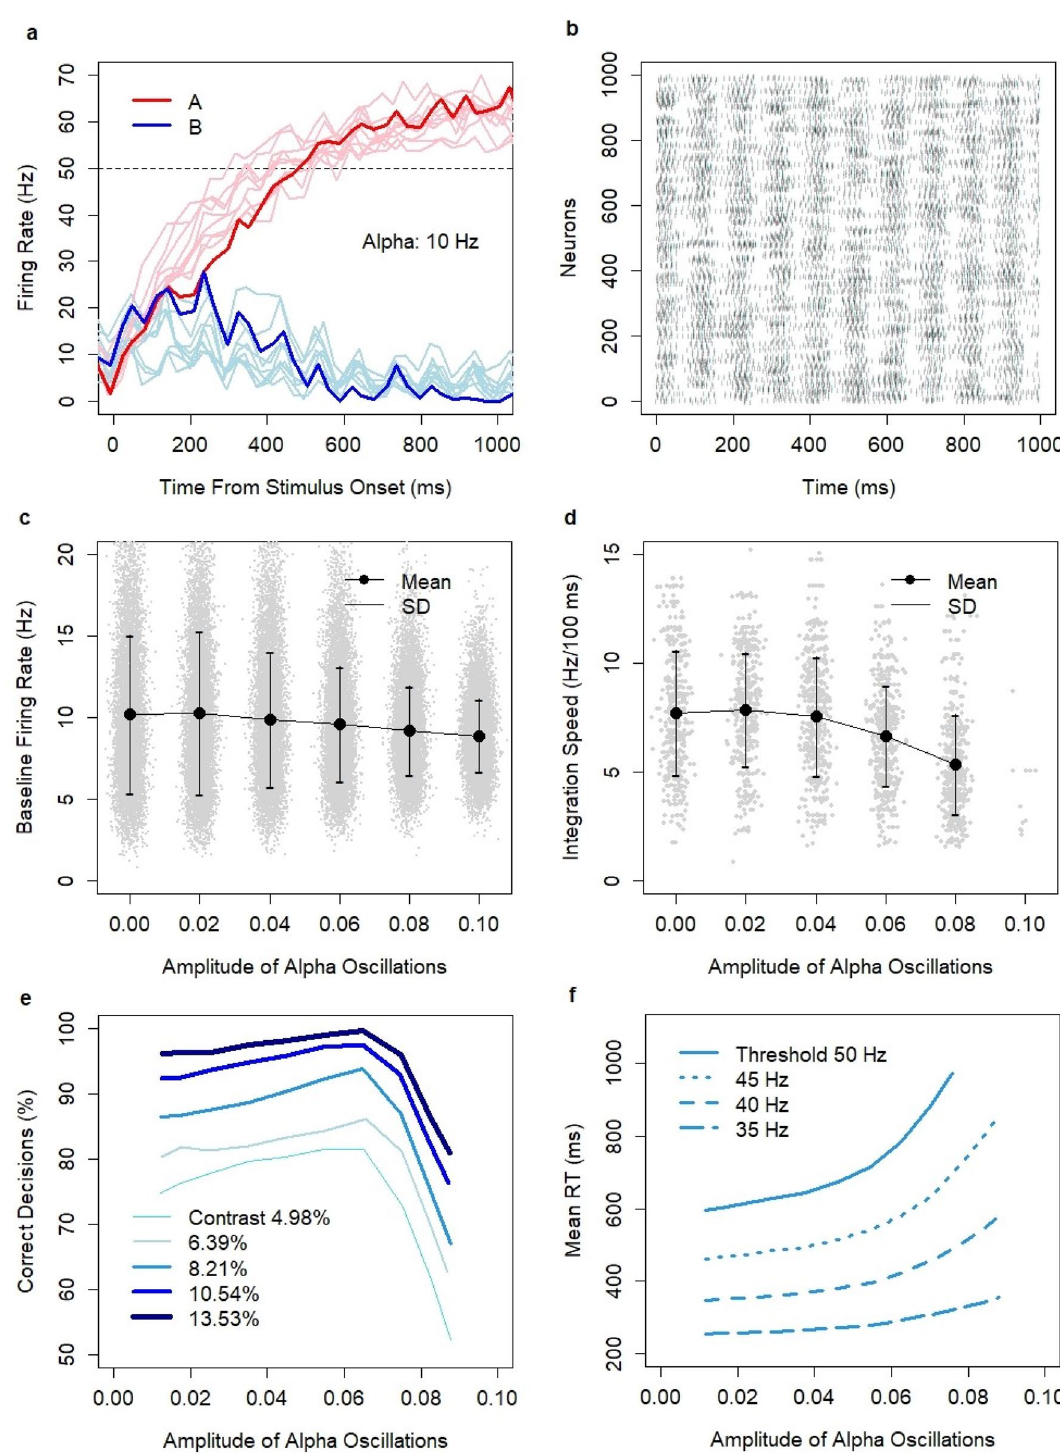
Figure 8. Interference between alpha oscillations (8–12 Hz) and the decision process. ( a ) Firing rate after stimulus onset in pools A and B for model runs with alpha oscillations (10 Hz) and coherence level c = 51.2% (where coherence describes task difficulty in dot motion discrimination experiments, see Methods). ( b ) Spiking activity of neurons in the decision system during a spontaneous model run with alpha oscillations (10 Hz). ( c ) Baseline firing rate (Hz): average in the decision set during a spontaneous run with alpha oscillations of random frequency (8–12 Hz); time bins 100 ms. ( d ) Integration speed (Hz/100 ms): average based on N = 2351 model runs with alpha oscillations of random frequency (8–12 Hz) and random contrast levels: 4.98–13.53%; time bins 30 ms. ( e ) Discriminatory power as a function of the amplitude of alpha oscillations (8–12 Hz) for different contrast levels and threshold 50 Hz. ( f ) Reaction time (RT) as a function of the amplitude of alpha oscillations (8–12 Hz) for different thresholds (35–50 Hz) and medium contrast level